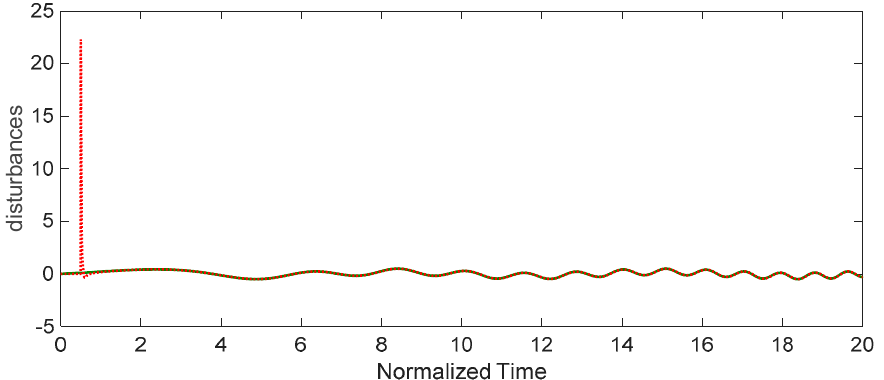
Figure 9. The control input of the closed-loop system based on the proposed control scheme in the presence of unknown disturbance.